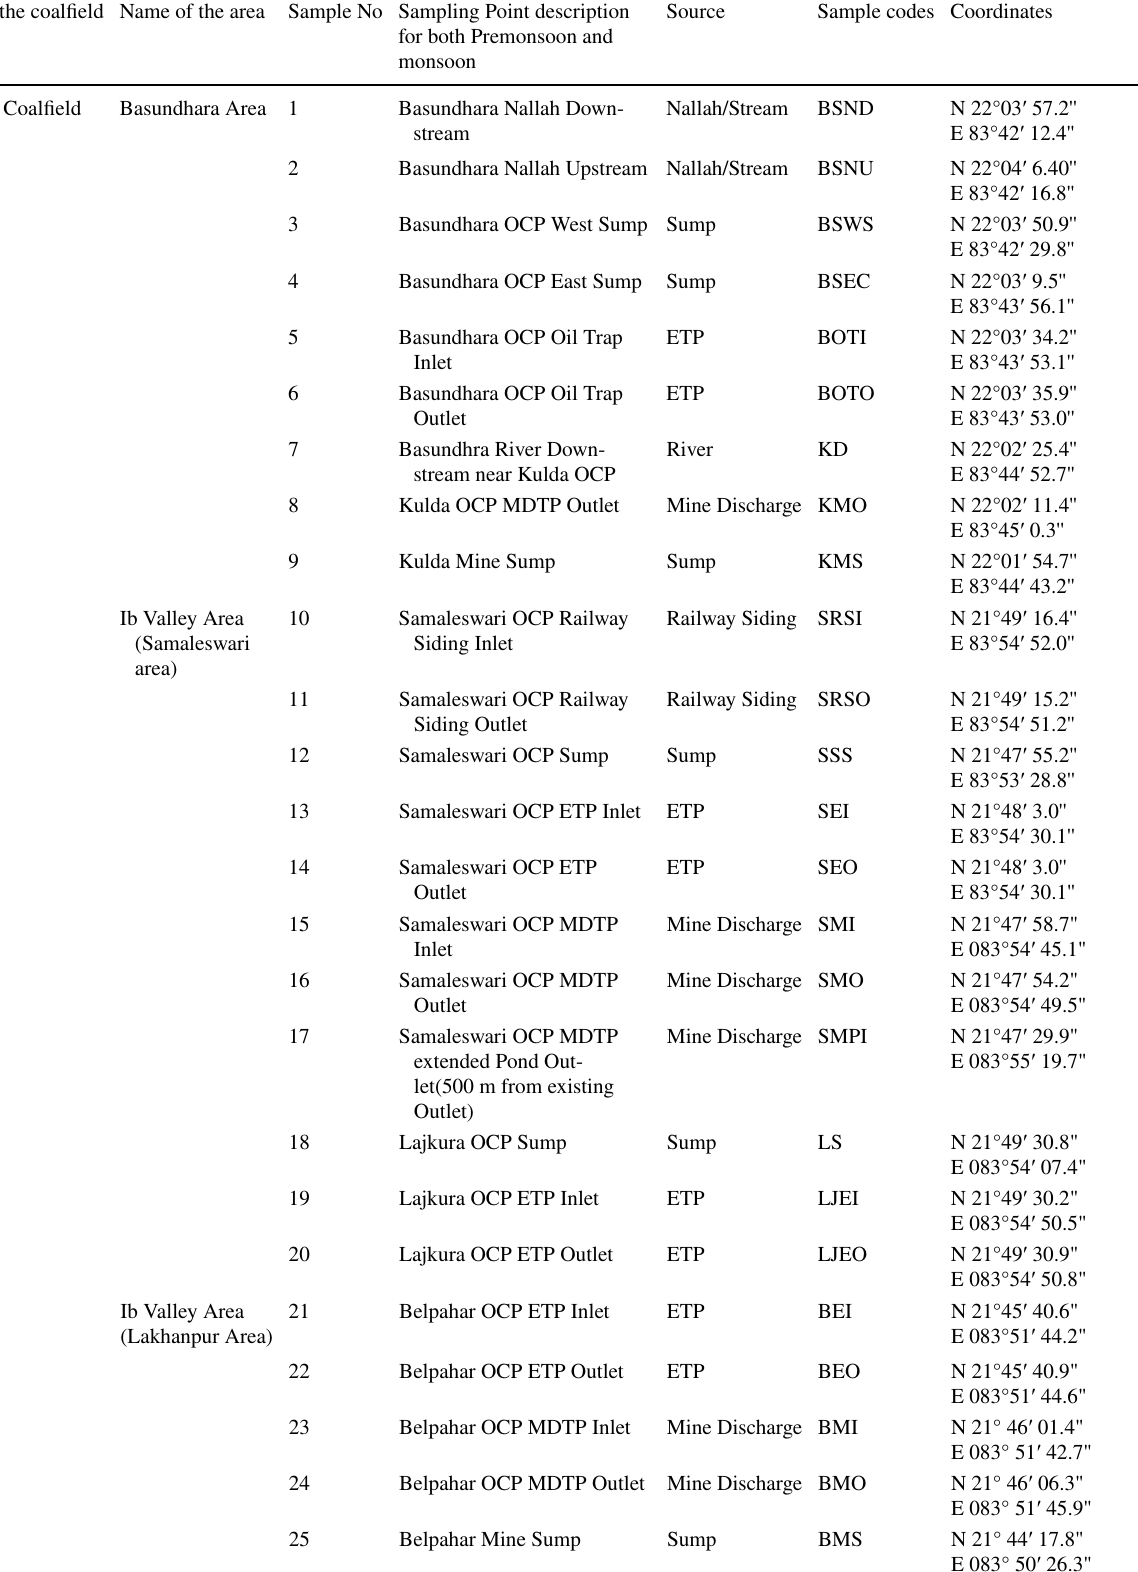
Table 2 Details of water sampling locations and sources of Ib Valley Coalfield Name of the coalfield Name of the area Sample No Sampling Point description for both Premonsoon